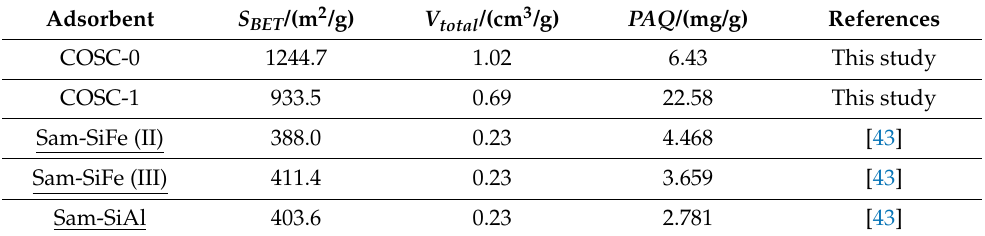
Table 3. Adsorption performance of different adsorbents for cooking fumes. Adsorbent S BET /(m 2 /g) V total /(cm 3 /g) PAQ